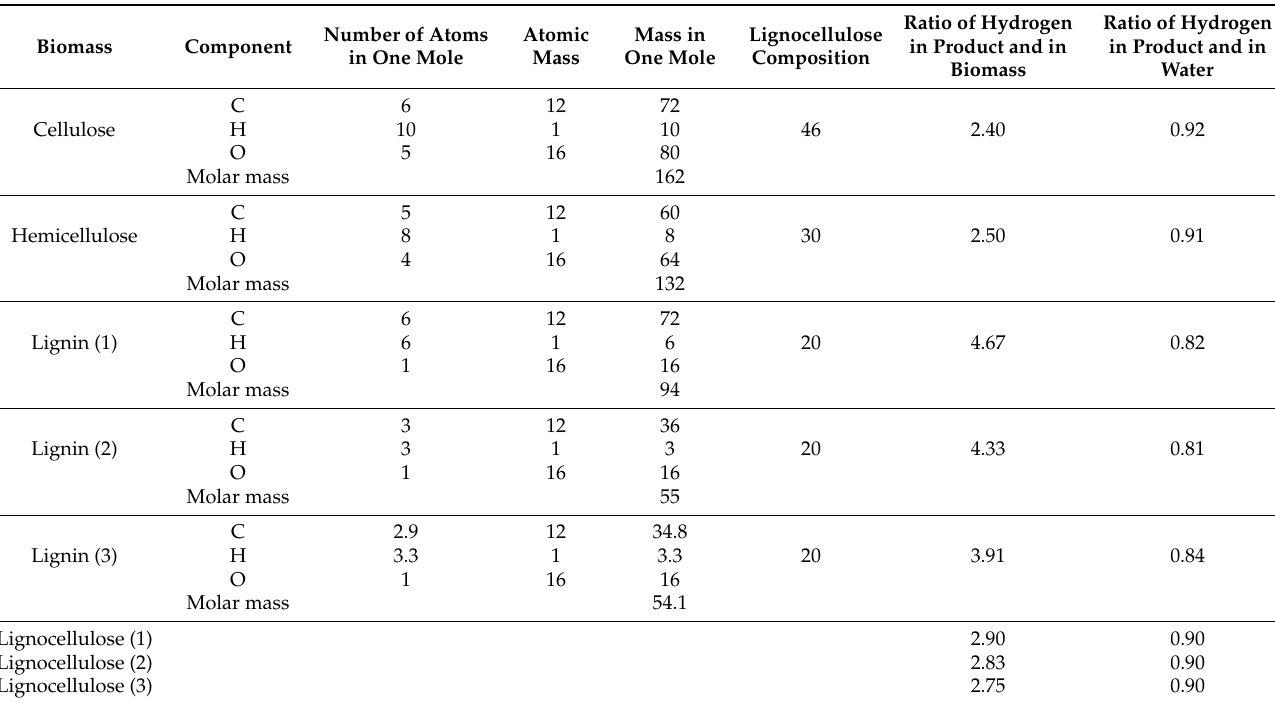
Table 3. Photocatalytic hydrogen yields from reacted biomass oxidation and water-splitting based on the validated reaction in Equation